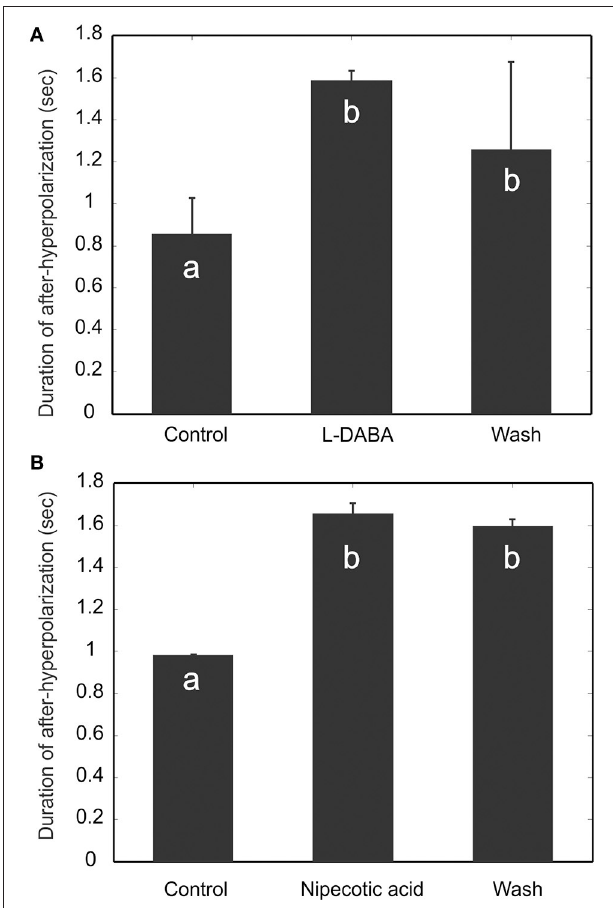
FIGURE 9 | Blocking GABA transporters increases the duration of afterhyperpolarization (AHP). Two GABA transporter blockers, L-DABA (A) and Nipecotic acid (B) , were used to treat the experimental preparations, and both blockers increase significantly the duration of AHP. The saline wash, however, does not fully reverse the drug effect. Different letters on the bar graphs indicate statistical significance ( Friedman test, p < 0.01 , n = 5